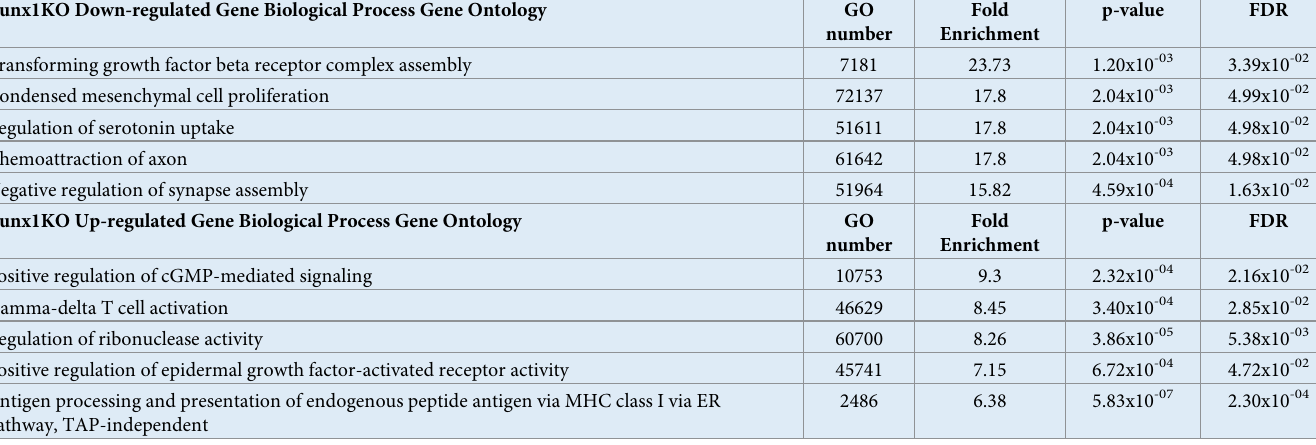
Table 1. Gene Ontology of Runx1 Regulated Genes. This table shows the top 5 gene ontology categories from the S2 Table, based on the fold enrichment for genes down-regulated in Runx1KO cells (top) or down-regulated in Runx1KO cells (bottom). Runx1KO Down-regulated Gene Biological Process Gene